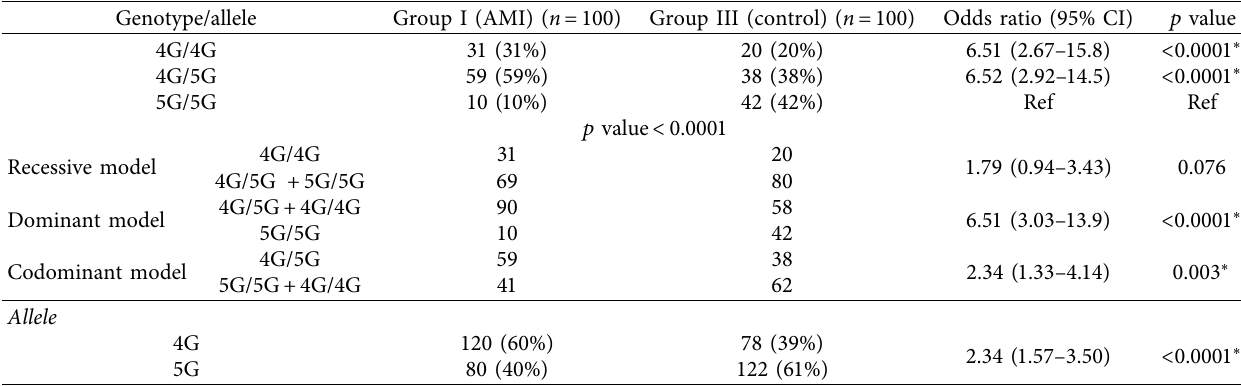
Table 3: Distribution of genotype and allelic frequency and association analysis of 4G/5G polymorphism with AMI cases under different genetic